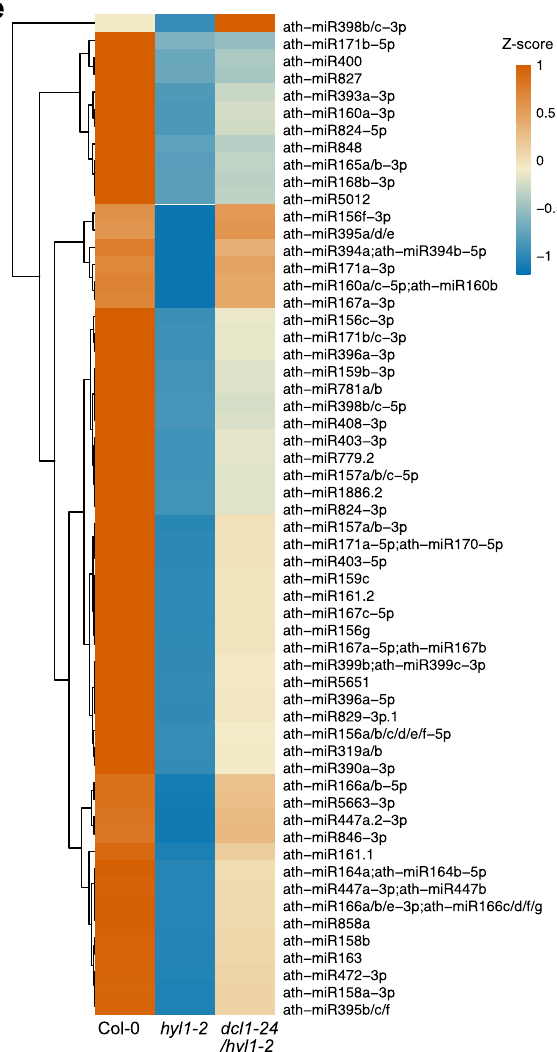
Fig. 2 | MicroRNA biogenesis is essential for thermomorphogenesis. a Representative images of 4-d-old Col-0, hyl1-2 , hs400/hyl1-2 , hs470/hyl1-2 , and hs471/hyl1-2 seedlings grown under 50 μ mol m − 2 s − 1 R light at either 21°C or 27°C. b Hypocotyl length measurements of the seedlings in ( a ) and their relative responses to the warm temperature. The open and gray bars represent hypocotyl length measurements at 21°C and 27°C, respectively. Error bars for the hypocotyl measurementsrepresents.d.( n =60seedlings).TheblacknumberabovetheCol-0 columns represents the percent increase in hypocotyl length (mean ± s.d., n =3 biological replicates) at 27°C compared with 21°C. The pink bars show the warm- temperature response of a mutant relative to that of Col-0 (set at 100%). Pink numbersshowthemean±s.d.valuesoftherelativeresponses.Differentlowercase letters above the bars denote statistically signi fi cant differences in the relative responses(ANOVA,Tukey ’ sHSD, p <0.01, n =3biologicalreplicates).Errorbarsfor